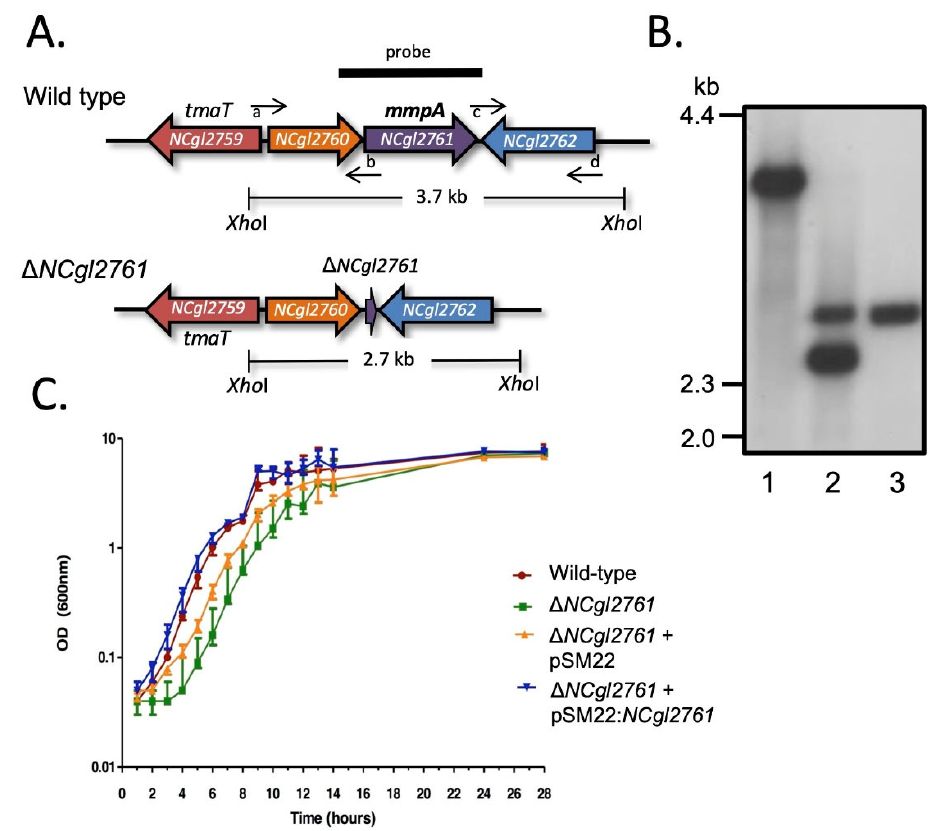
Figure 3. Disruption strategy and growth assessment of C. glutamicum Δ NCgl2761 . ( A ) Diagram showing the arrangement of genes in the NCgl2761 region of WT C. glutamicum (above) and ∆ NCgl2761 mutant (below). XhoI restriction sites, sizes of expected bands on Southern blot and position of the probe used are shown. Small horizontal arrows indicate the binding sites for the four primers used to construct the ∆ NCgl2761 mutant (a, NCgl2761 -left_F; b, NCgl2761 -left_R; c, NCgl2761 -right_F; d, NCgl2761 -right_R). ( B ) Southern blot analysis of XhoI-digested DNA of C. glutamicum WT (lane 1), a single cross-over strain (lane 2) and the ∆ NCgl2761 mutant (lane 3). Positions of DIG-labelled λ DNA standards digested with HindIII are indicated in kilobase pairs (kb). ( C ) Growth curves of WT C. glutamicum , the ∆ NCgl2761 mutant and complementation strains in liquid BHI medium. Each strain was grown to saturation, then diluted 1:100 in BHI medium. Triplicate cultures were sampled at the times indicated to determine the optical density (OD) at a wavelength of 600nm. Growth curves were plotted as mean SD.